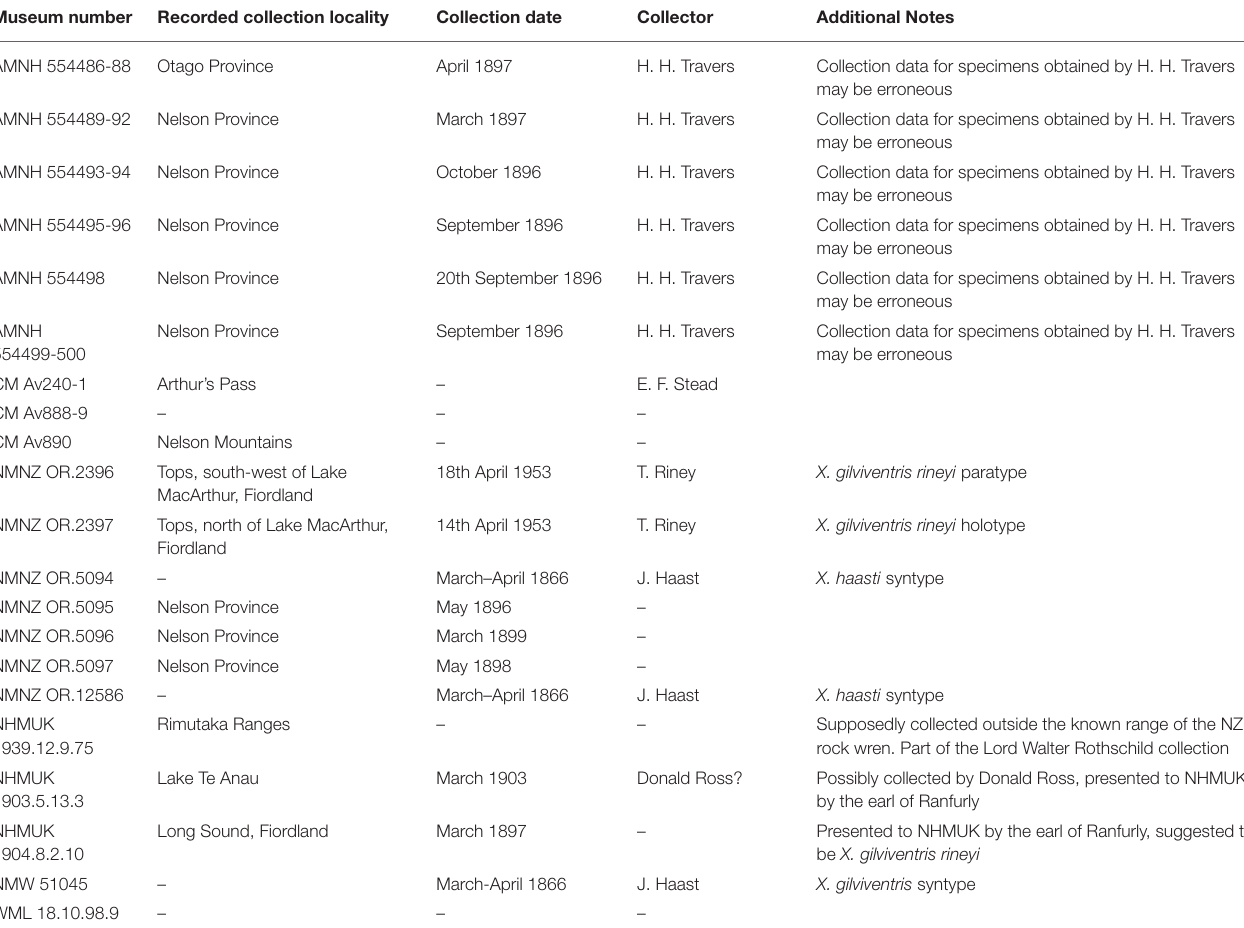
TABLE 1 | Registration and collection information of the New Zealand rock wren ( Xenicus gilviventris ) museum specimens examined by this